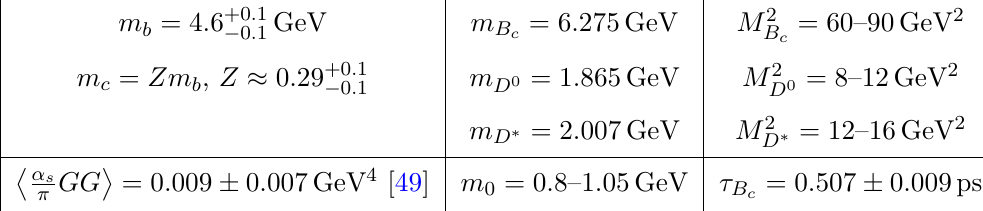
Table 2 . Parameters used in the QCDSR